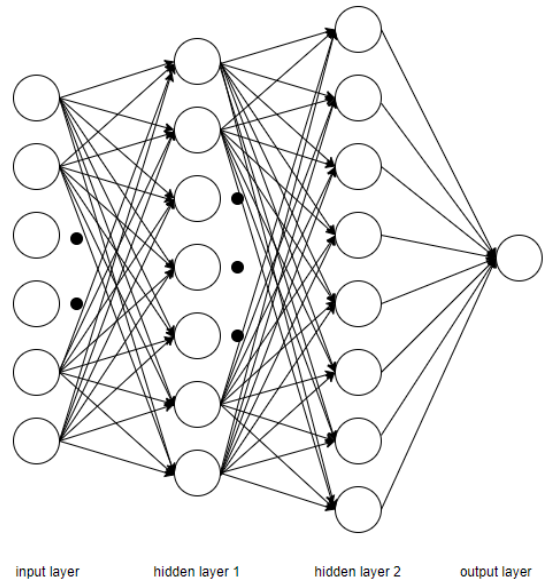
Figure 3. Structure of neural network model.